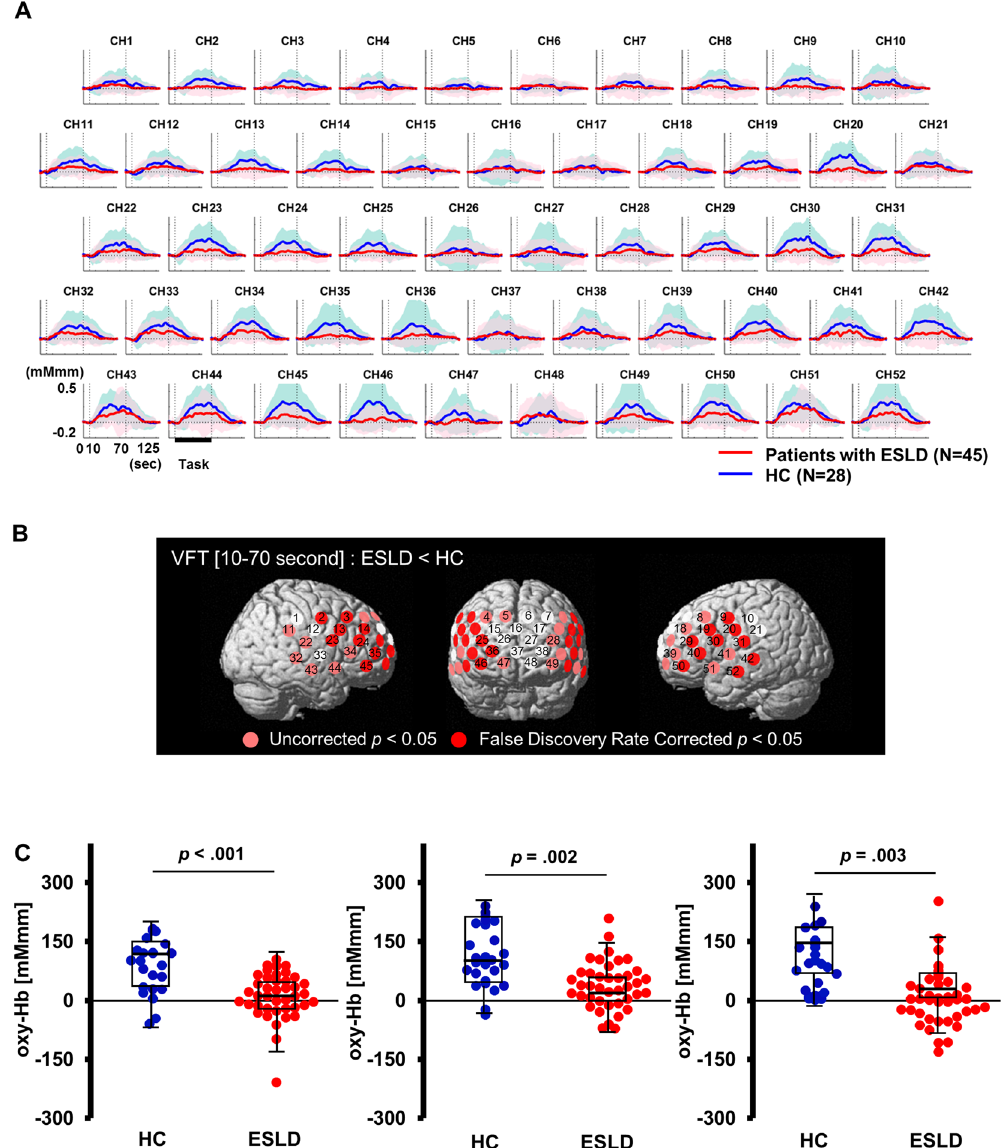
Figure 2. Differences between patients with end stage liver disease (ESLD) and healthy controls (HC) in the verbal fluency task (VFT). ( A ) The graphs show oxygenated hemoglobin ([oxy-Hb]) concentration change during the VFT. Standard deviations for each group are shown with thick bands. ( B ) Channels on the 3D topographic maps indicate differences in [oxy-Hb] integral value between patients with ESLD and HC (pink circles: p < 0.05 false discovery rate uncorrected, red circles: p < 0.05 false discovery rate corrected). ( C ) The graphs show differences of [oxy-Hb] integral value between HC and patients with ESLD in channel 20: left postcentral gyrus (left); channel 40: left inferior frontal gyrus (middle); and channel 46: right middle frontal gyrus (right). The upper and lower borders of the box plot marks the 75th and 25th percentiles, respectively and the middle line indicating the median value. Whiskers above and below the box indicate the highest datum still within 1.5 interquartile range (IQR) of the upper quartile, and the lowest datum still within 1.5 IQR of the lower quartile, respectively. * p < 0.05, ** p < 0.01 determined by t-tests with equal